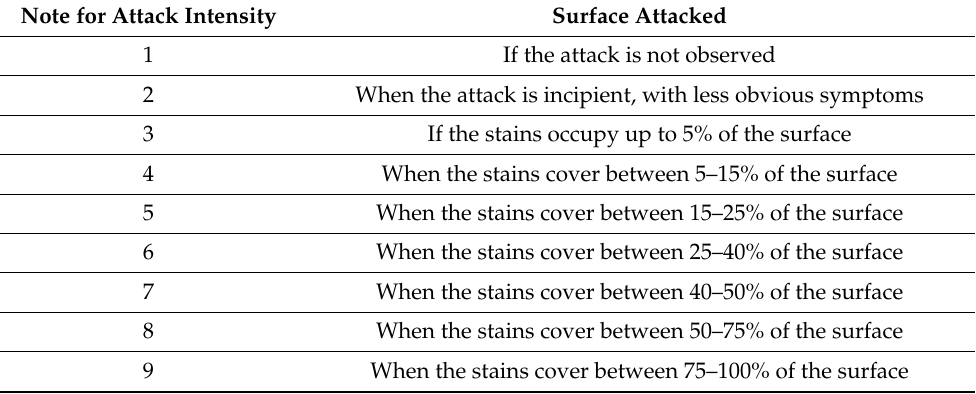
Table 4. Scale of attack intensity